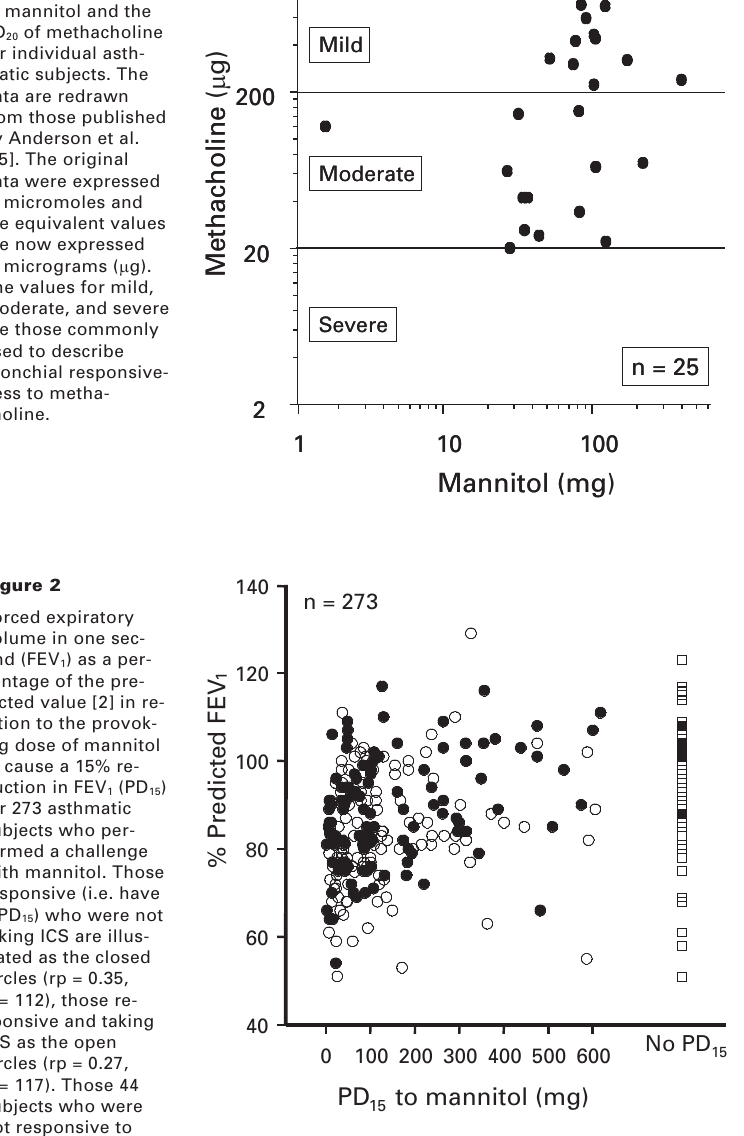
The association between the PD 15 of mannitol and the PD 20 of methacholine for individual asth- matic subjects. The data are redrawn from those published by Anderson et al. [65]. The original data were expressed in micromoles and the equivalent values are now expressed in micrograms ( µ g). The values for mild, moderate, and severe are those commonly used to describe bronchial responsive- ness to metha- choline.